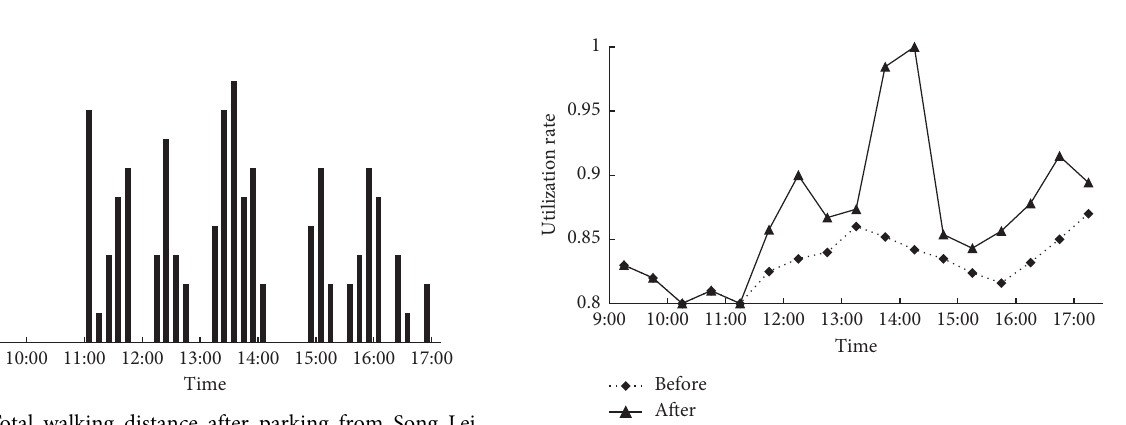
Figure 13: Utilizing rate of parking lots in Peace